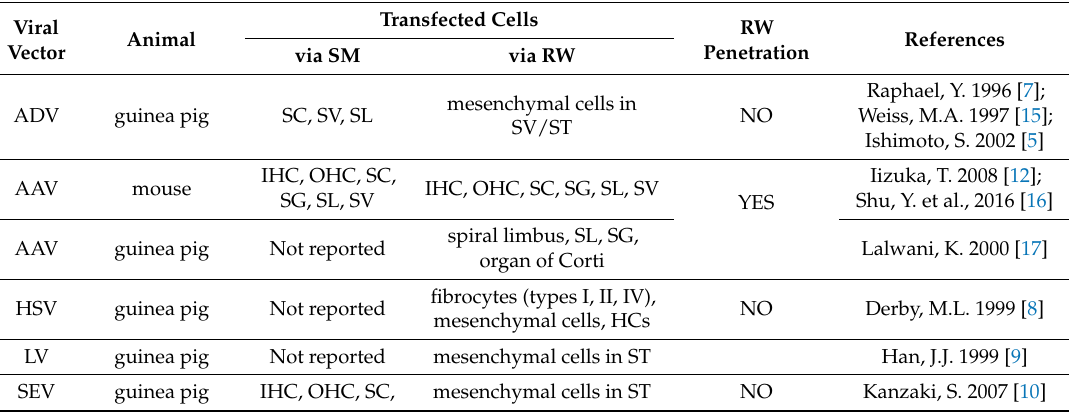
Table 1. Comparison among viral vectors in inner